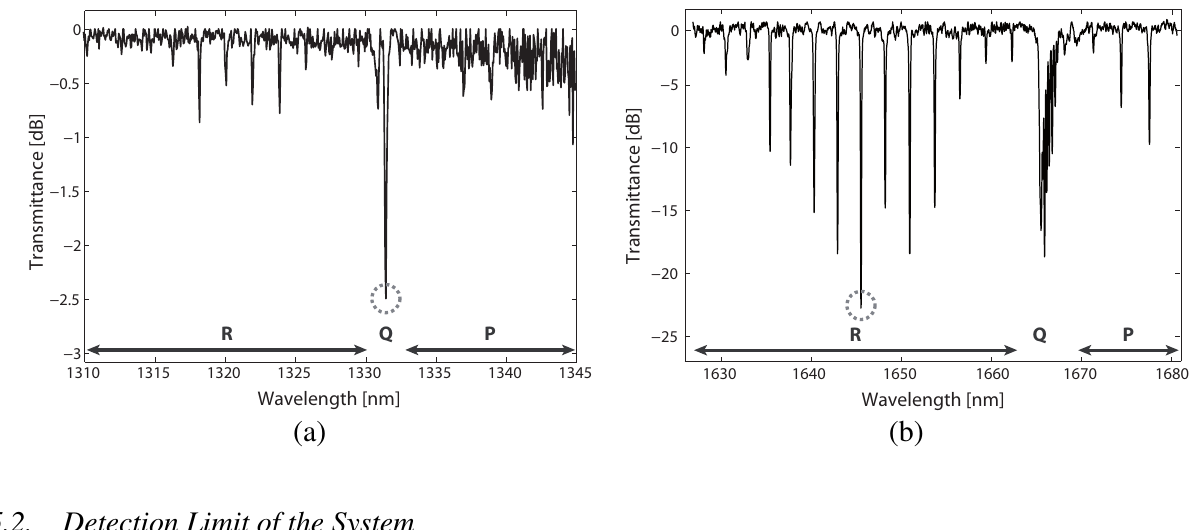
Figure 5. Transmission spectrum of methane at (a) the ν HC1300 fibre, and (b) at 2 ν are labeled. The selected features for methane detection are